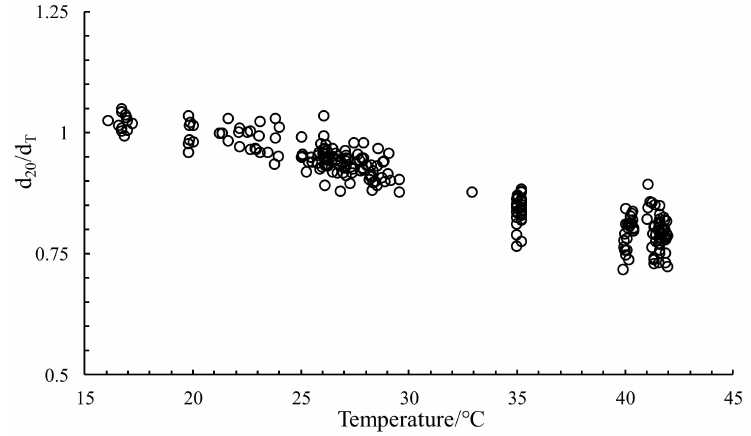
Figure 7. Load center deflection fitting results.